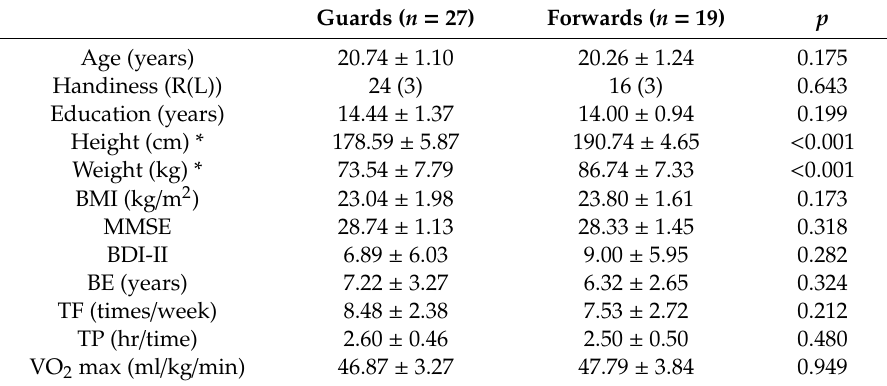
Table 1. Demographic characteristics (mean ± SD) for the guards and the forward groups. Guards ( n =